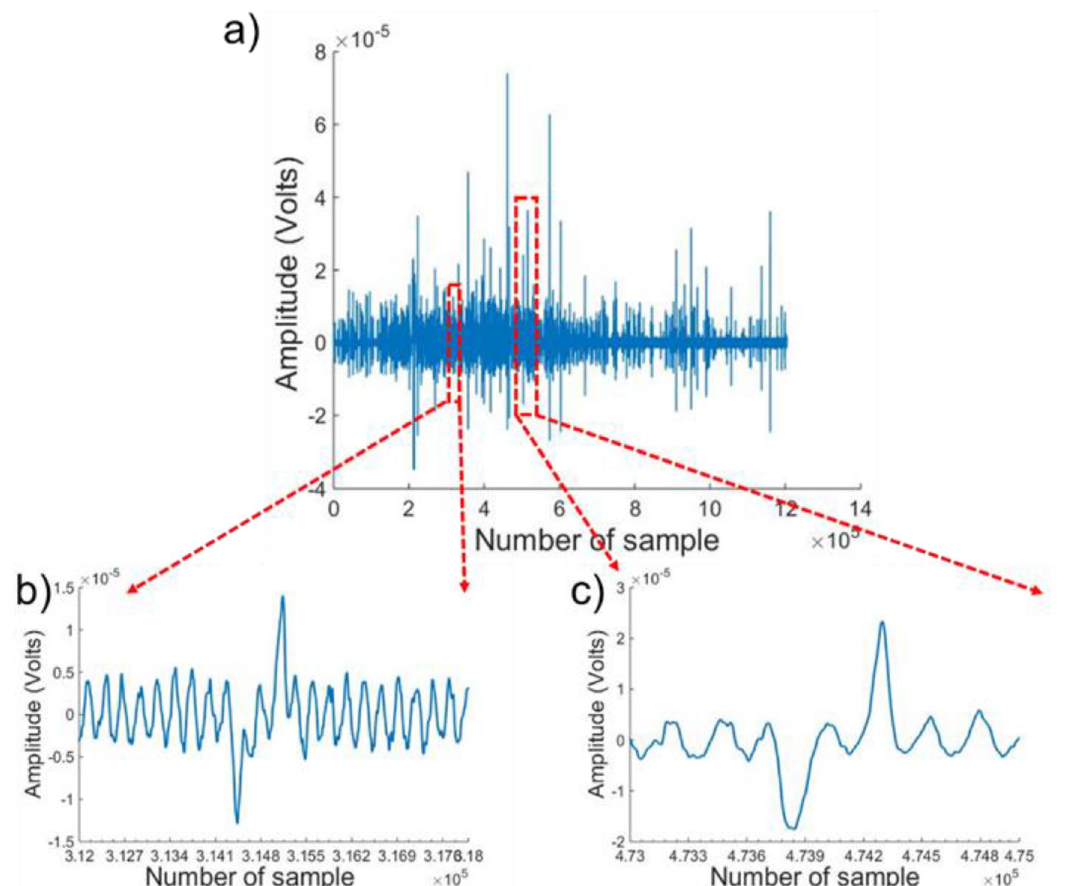
Figure 8. Bipolar pulses amplitude measured for the translocation of the leukemia cells through the microchannel. ( a ) Pulse’s amplitude recorded for a heterogeneous population of leukemia cells for 1200 s at